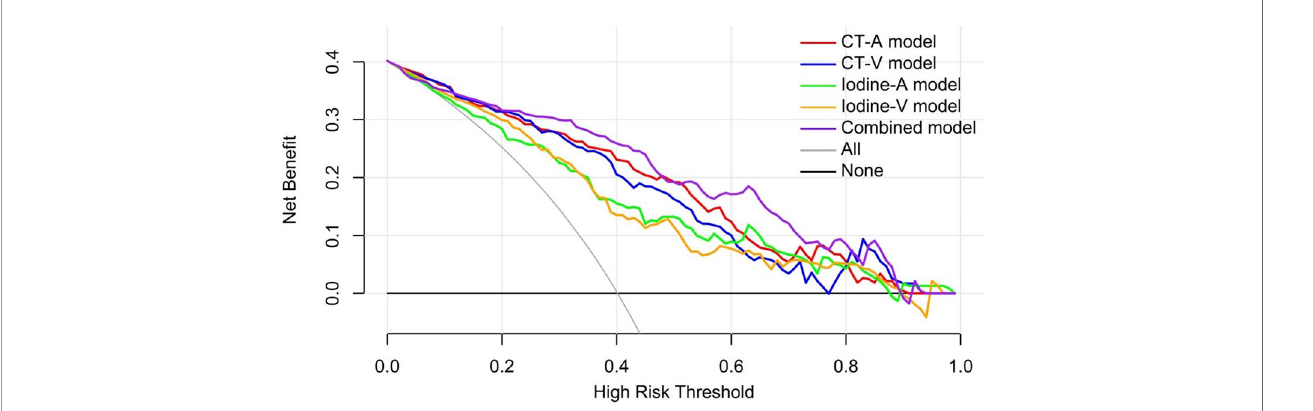
FIGURE 6 | Decision curve analysis for the predictive models in the independent testing set. The gray line and black line represented situations in which all lymph nodes were metastatic and no lymph nodes were free of cancer, respectively.